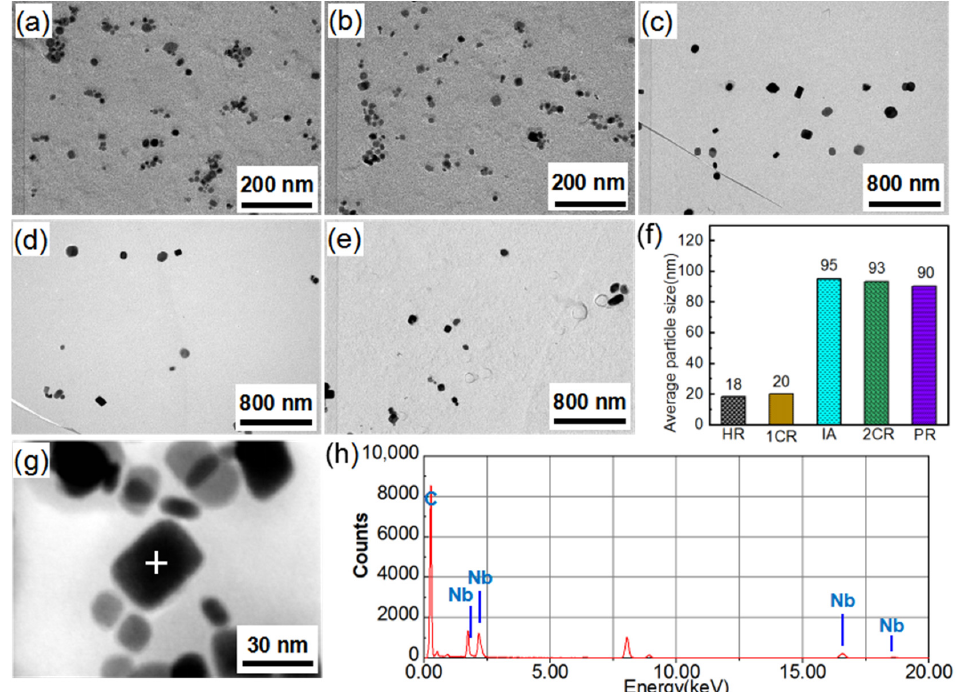
Figure 4. TEM micrographs of precipitates in the Fe 81 Ga 19 thin sheet under different stages: ( a ) HR, ( b ) 1CR, ( c ) IA, ( d ) 2CR, and ( e ) PR. ( f ) The size distribution for different processes. ( g , h ) EDS of precipitates in the hot-rolled sheets.